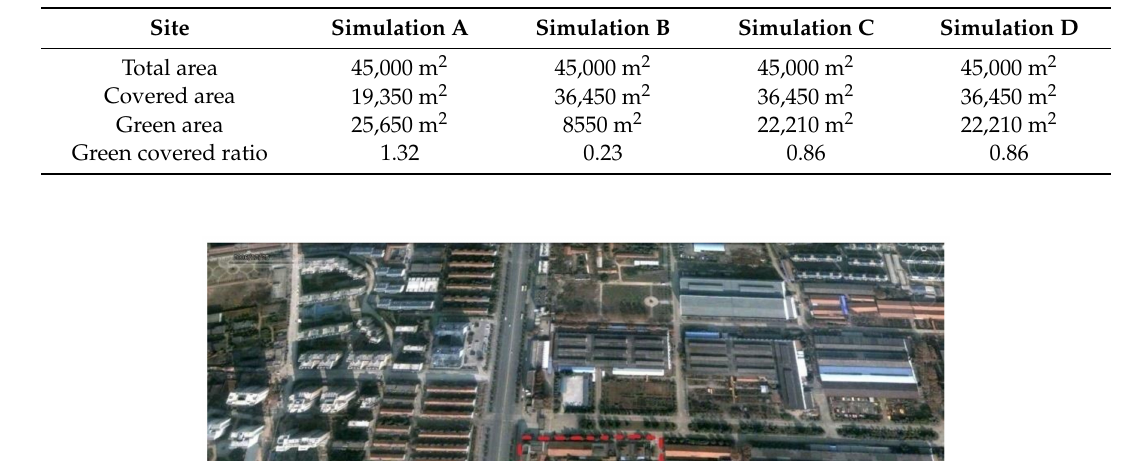
Table 2. Basic information of the selected site.